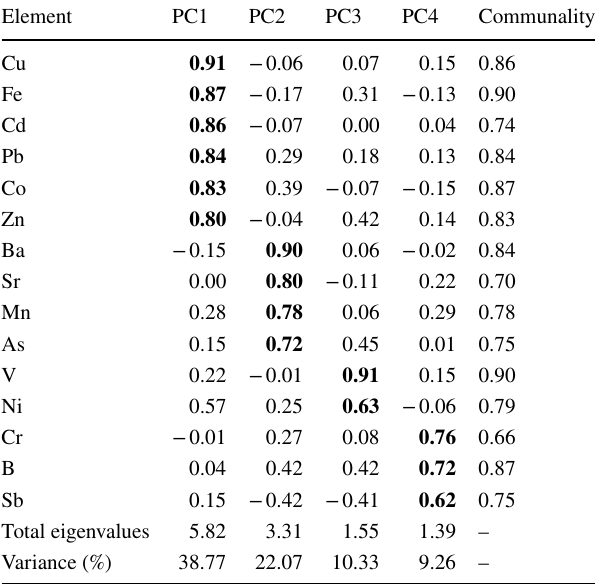
**Correlation is significant at the 0.01 level (2-tailed) *Correlation is significant at the 0.05 level Table 5 Varimax rotated factor loadings and communalities for the river water dataset